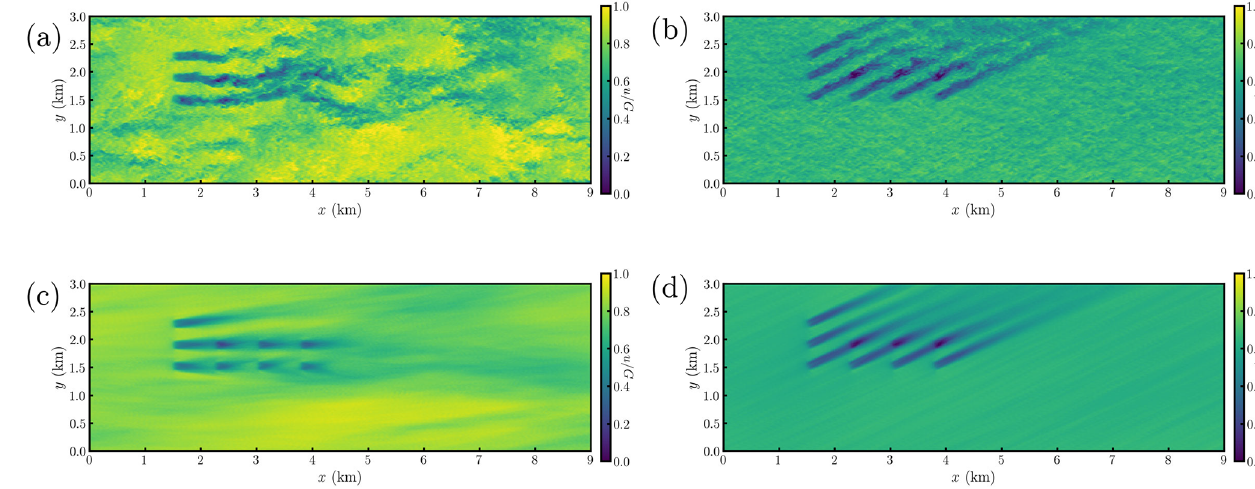
Figure 4. Hub-height streamwise velocity during (a, c) unstable and (b, d) stable ABL conditions for the baseline yaw-aligned control case. Instantaneous snapshots are shown in (a) and (b) , and 10min moving averaged flow fields are shown in (c) and (d) . The streamwise velocity zoomed in to focus on the wind farm area is shown in Fig. B2. Table 2. The diurnal cycle atmospheric boundary layer wake steering cases. Cases with α forecast checked use the DirectionEstimation (Algorithm 1) to forecast the wind direction over future time T . Cases with optimization under uncertainty (OUU) use the OUU methodology described in Sect. 2. Each case represents a separate LES